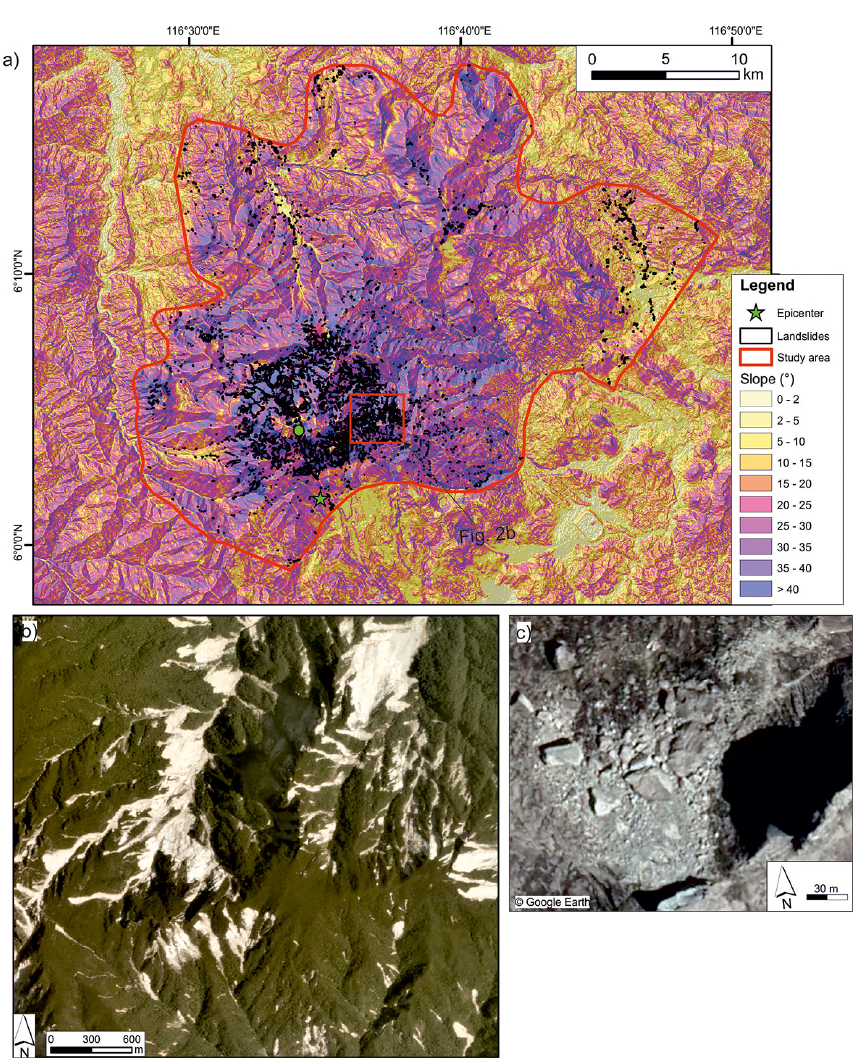
Figure 2. (a) Slope map and hillshade derived from 30m resolution ALOS DEM; the red polygon is the study area, while landslides are shown in black; (b) Planet Labs image (3m resolution) taken on 18 March 2016 showing widespread landslides; (c) © Google Earth image of a rockfall on top of Mt. Kinabalu (location is the green dot in panel a